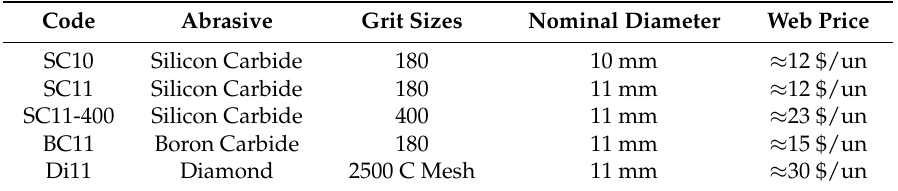
Table 1. Different flexible abrasive tools used in tests.